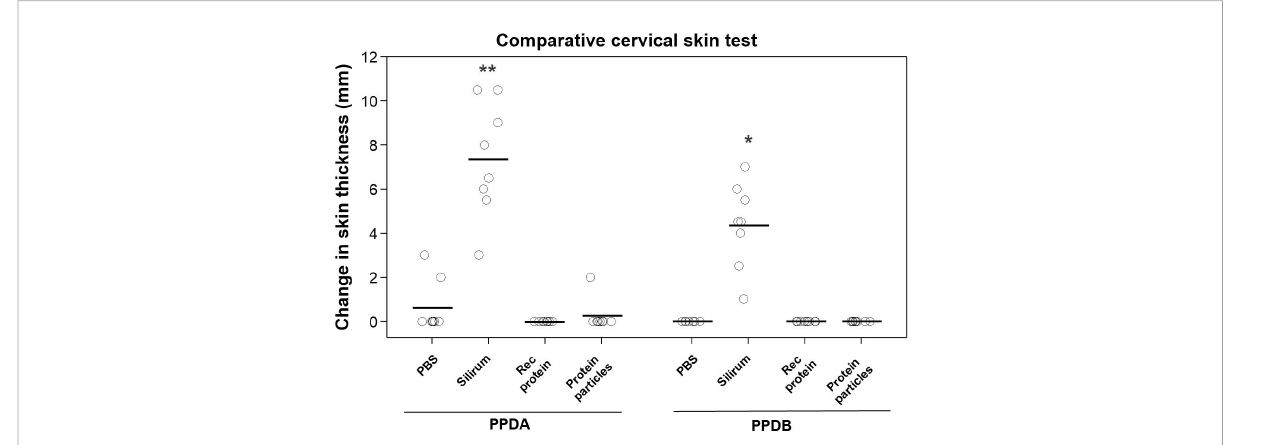
FIGURE 5 Comparative cervical tuberculin skin test in vaccinated animals. Skin thickness was measured before and at 72 h after injecting 0.1 mL of PPDA or PPDB intradermally at the side of the neck. Mean is represented by ‘ ─ ’ for each group. Signi fi cance is represented by between different groups. Statistical signi fi cance was calculated compared with the PBS control group (* = P < 0.05; ** = P <